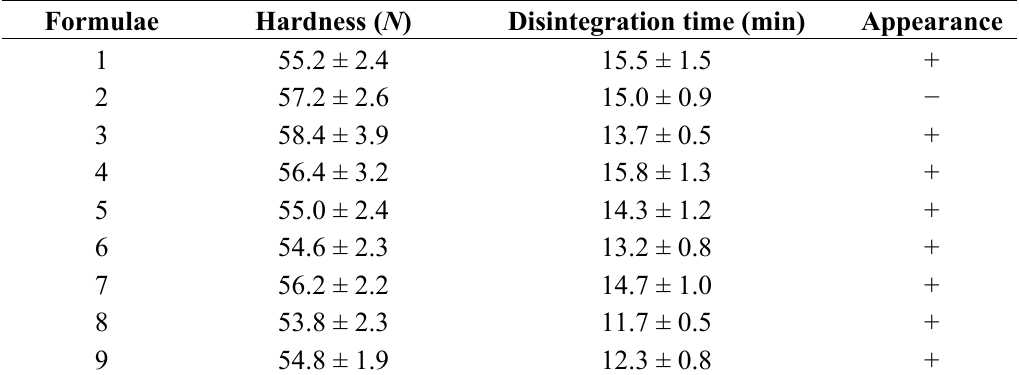
Table 1. Screening test results of formulation designation (means ± SD, n =